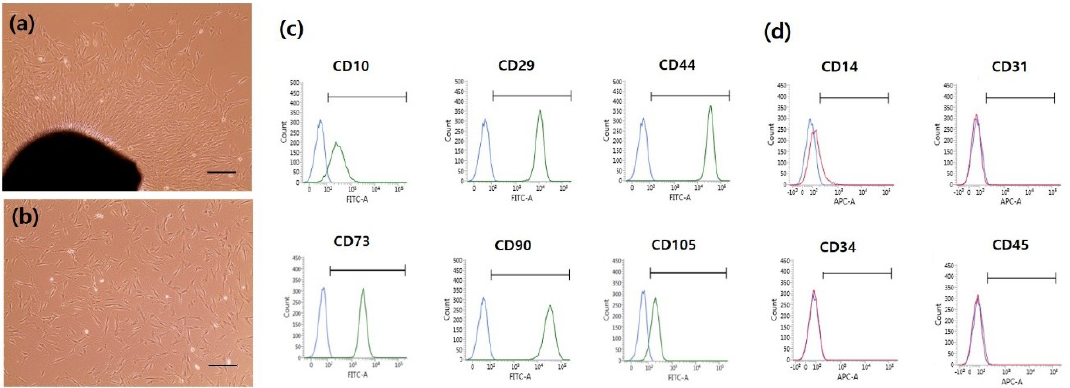
Figure 1. ( a ) The morphology of primary supernumerary tooth-derived human dental pulp stem cells (hDPSCs). ( b ) In vitro cultured hDPSCs at passage 3. The scale bar is 100 μm. ( c ) Characterization of hDPSCs at passage 4 by fluorescence-activated cell sorting (FACS) analysis. Mesenchymal stem cell markers (92.48% CD10; 100% CD29; 100% CD44; 100% CD73; 100% CD90; 88.13% CD105) were highly expressed in hDPSCs compared to ( d ) only a small degree of hematopoietic and endothelial marker expression (20.11% CD14; 0.53% CD31; 1.24% CD34; 0.82% CD45).